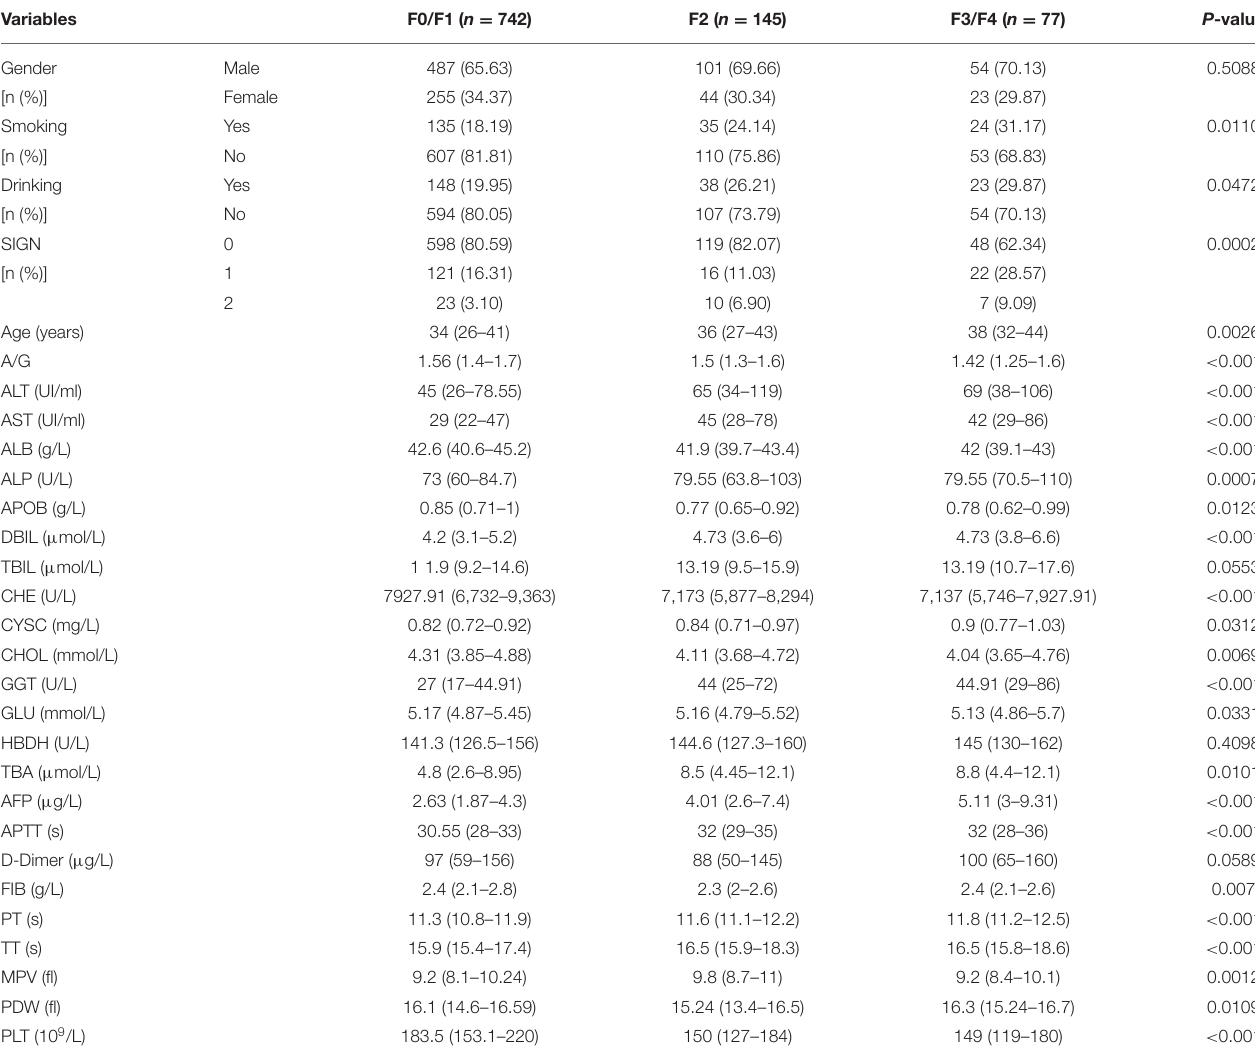
TABLE 1 | Clinical and laboratory characteristics of HBV patients in different